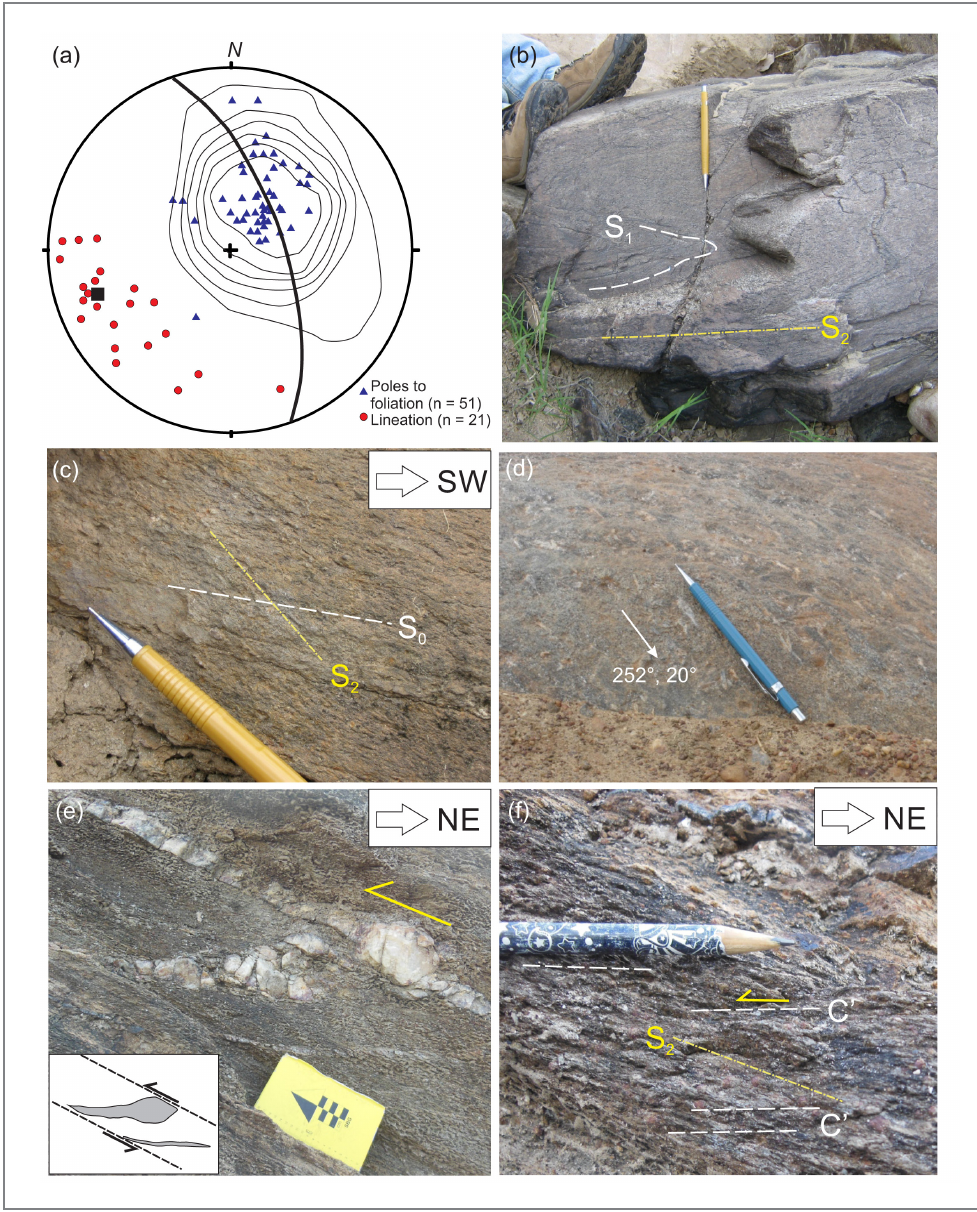
Figure 3 - Structural aspects of the study area. (a) Poles to the main foliation (S2) and their Kamb contours (2 sigma intervals), and mineral lineations plotted on equal-area (lower hemisphere) projections. The great circle is fitted to the distribution of the foliation poles and the square indicates its pole (251°, 23°). (b) Intrafolial isoclinal folds. (c) Mica foliation oblique to bedding. (d) Porphyroblasts of kyanite defining a mineral lineation. (e, f) Kinematic shear criteria. (e) En-echelon quartz veins. (f) C’-type shear